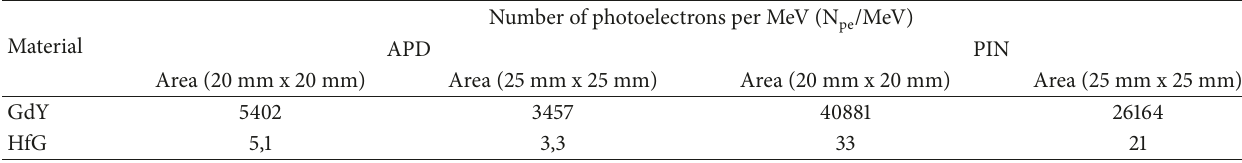
Table 1: Number of photoelectrons per MeV (N pe /MeV) produced for different scintillator back face areas and photodetector combinations.